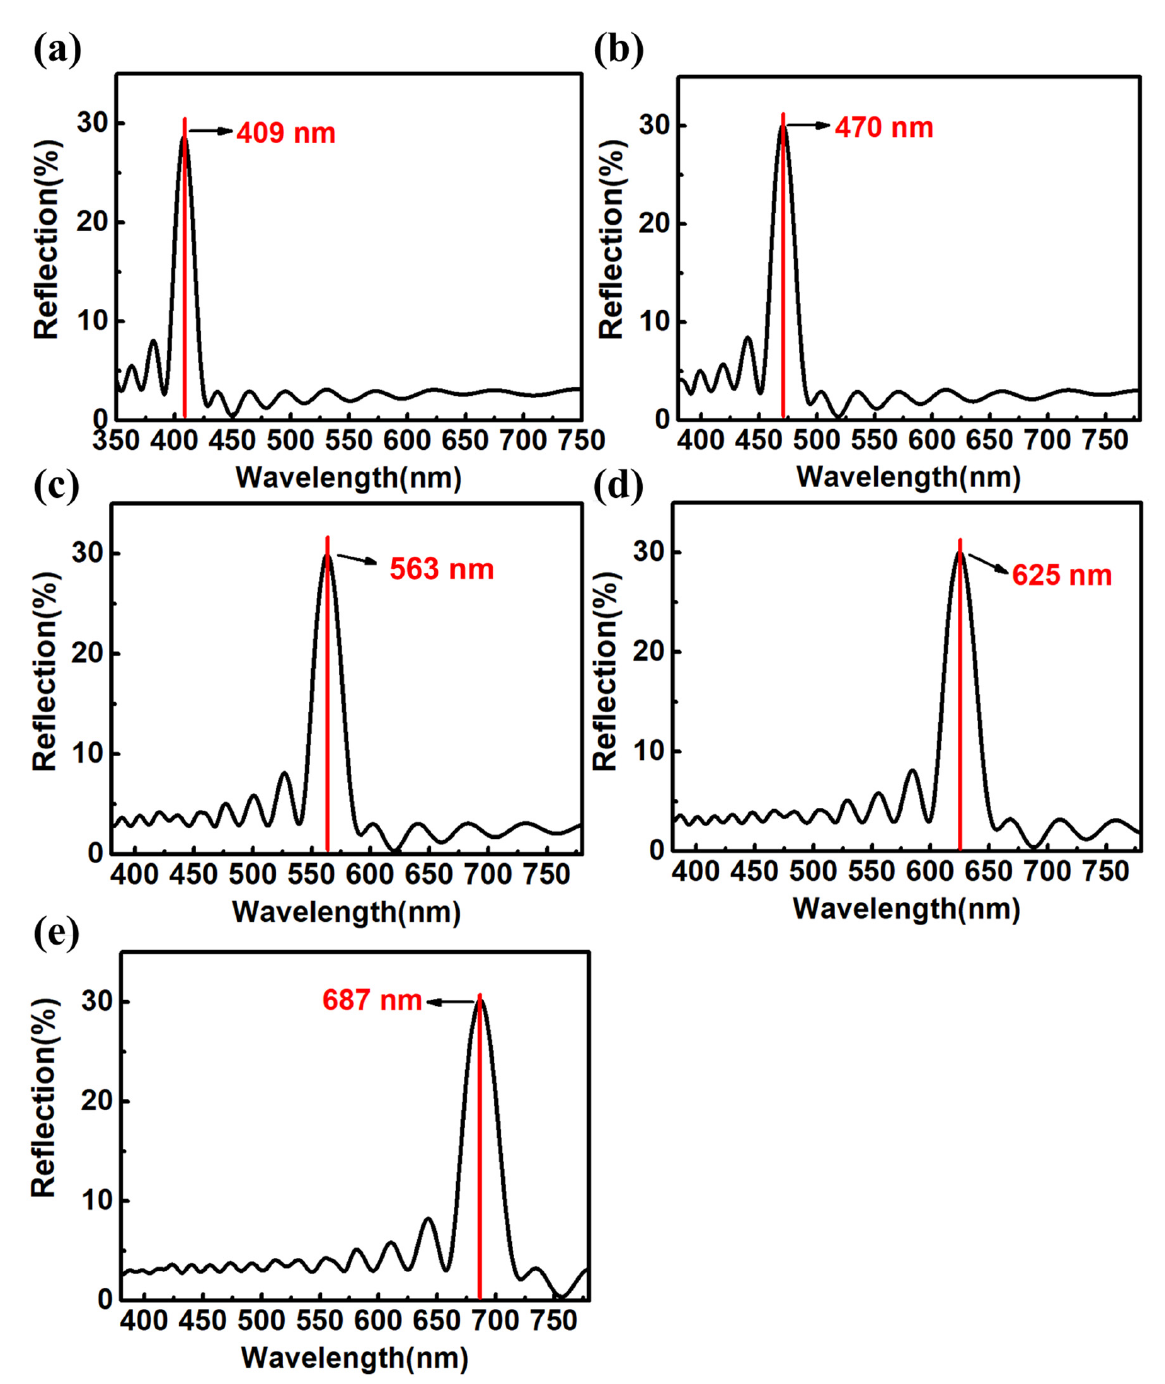
Figure 7. Simulation results of reflection spectra of IO structure containing PEGDA matrix and voids after response to water, where the void sizes in the system are ( a ) 130 nm; ( b ) 150 nm; ( c ) 180 nm; ( d ) 200 nm; and ( e ) 220